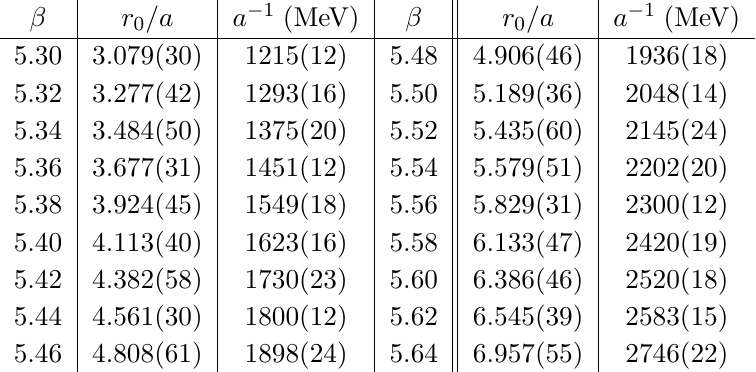
Table 1 . The coupling constant β and the lattice spacing matched by using r 0 = 0 . 5 fb . = e iaA µ , V U µ